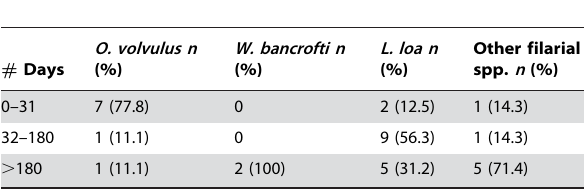
Table 2. Trip duration by filarial infection among nonendemic visitors